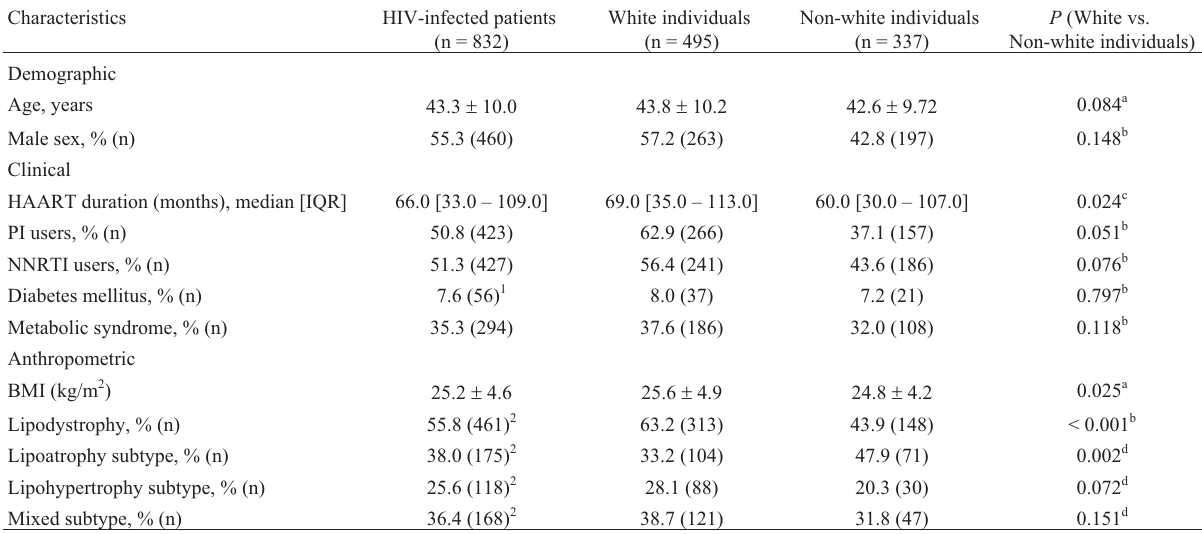
Table 1 - Main demographic, clinical and anthropometric characteristics of 832 HIV-infected individuals on HAART.